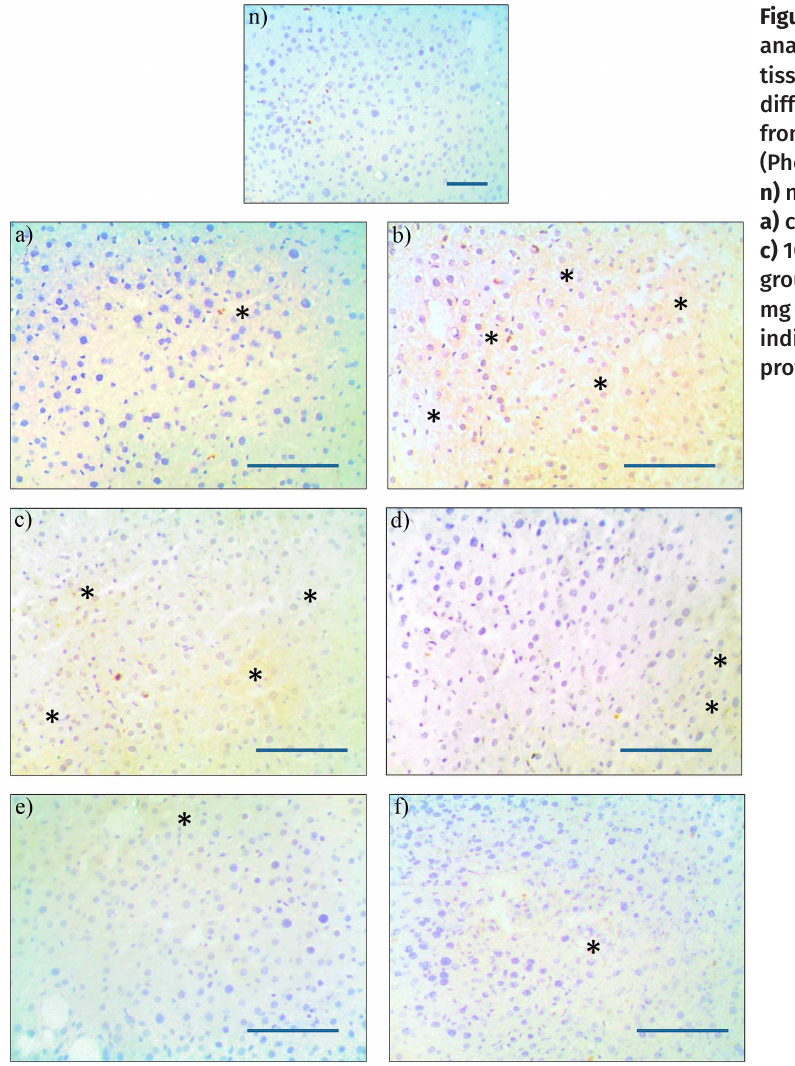
Figure 14. Immunohistochemical analysis of anti-MCL-1 in liver tissue of mdx mice treated with different doses of aqueous extract from leaves of Miconia ferruginata (Photomicrography, 1:500 dilution). n) negative control of the